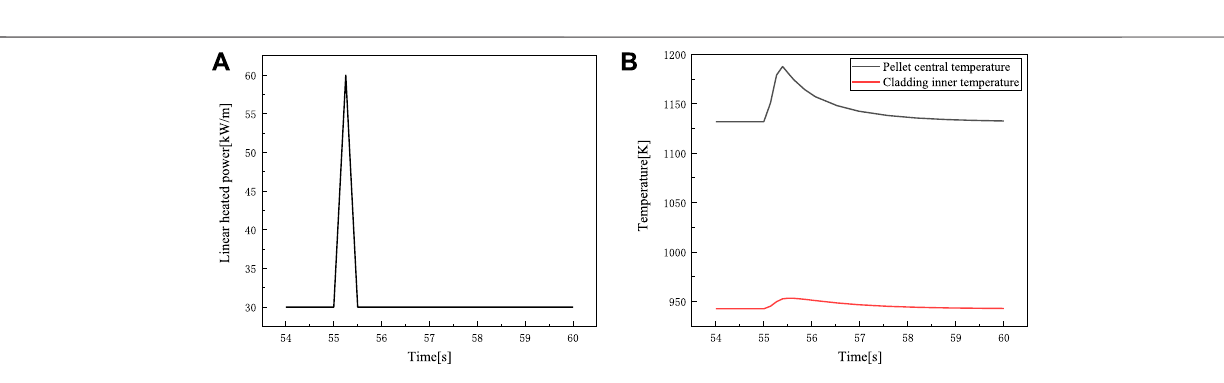
Frontiers in Energy Research |